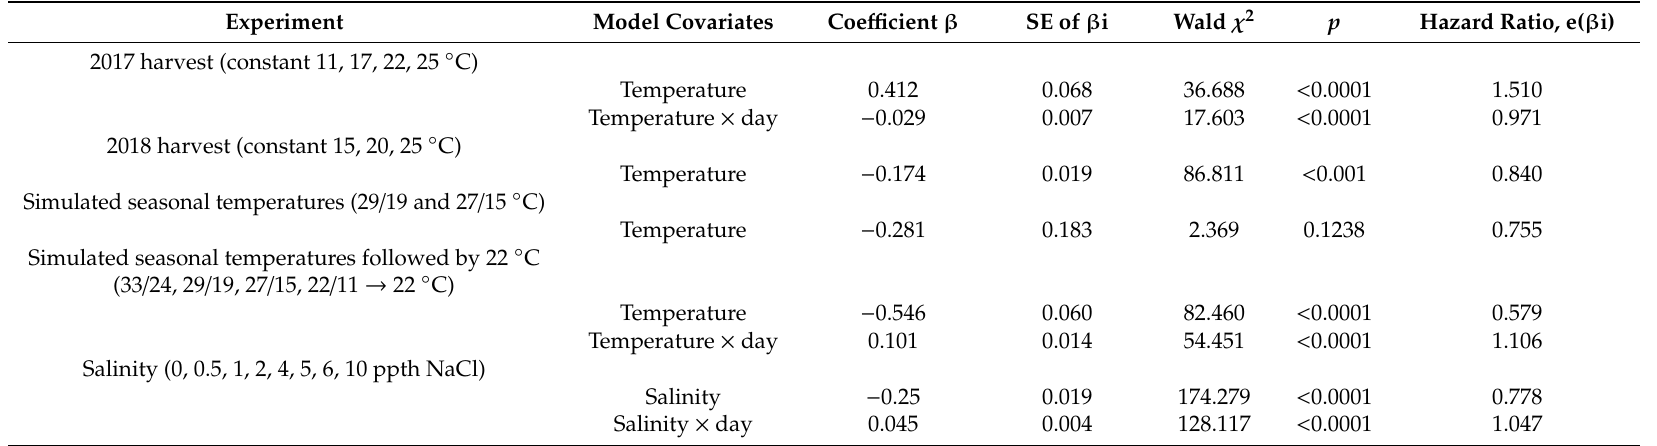
Table 2. Summary of Cox models for Linum arenicola seeds exposed to various constant temperatures, simulated seasonal temperatures, and salinity concentrations. Alternating temperatures simulate the average daily maxima and minima for the winter (22 / 11 ◦ C), early spring or late autumn (27 / 15 ◦ C), early autumn or late spring (29 / 19 ◦ C), or summer (33 / 24 ◦ C) throughout